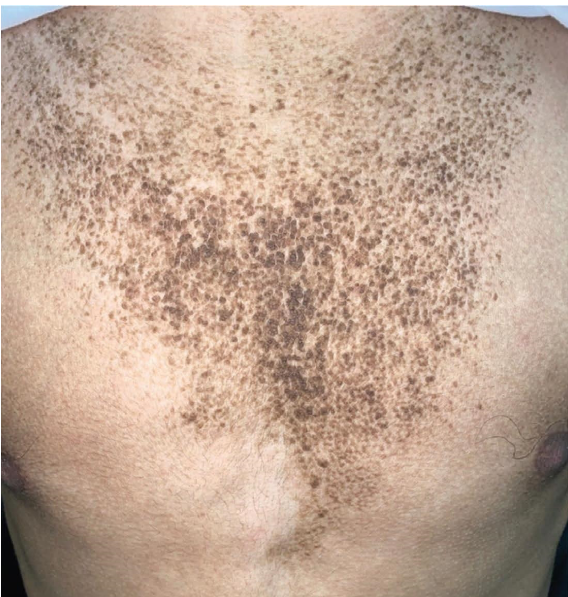
Figure 1: Hyperpigmented, hyperkeratotic, confuent macules, and papules that coalesce into reticulated plaques over the upper